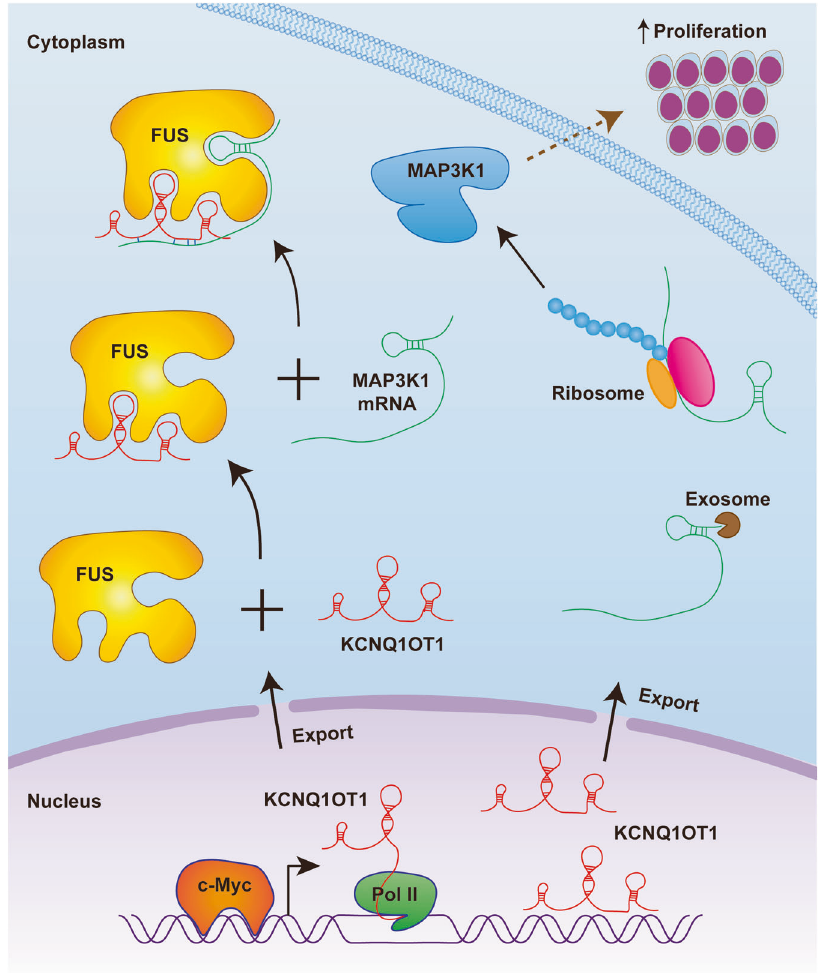
Fig. 7 Schematic diagram of lncRNA-KCNQ1OT1 functions to promote proliferation in APL. Light blue background shows cytoplasm, light pink background shows nucleus. Pol II: RNA polymerase